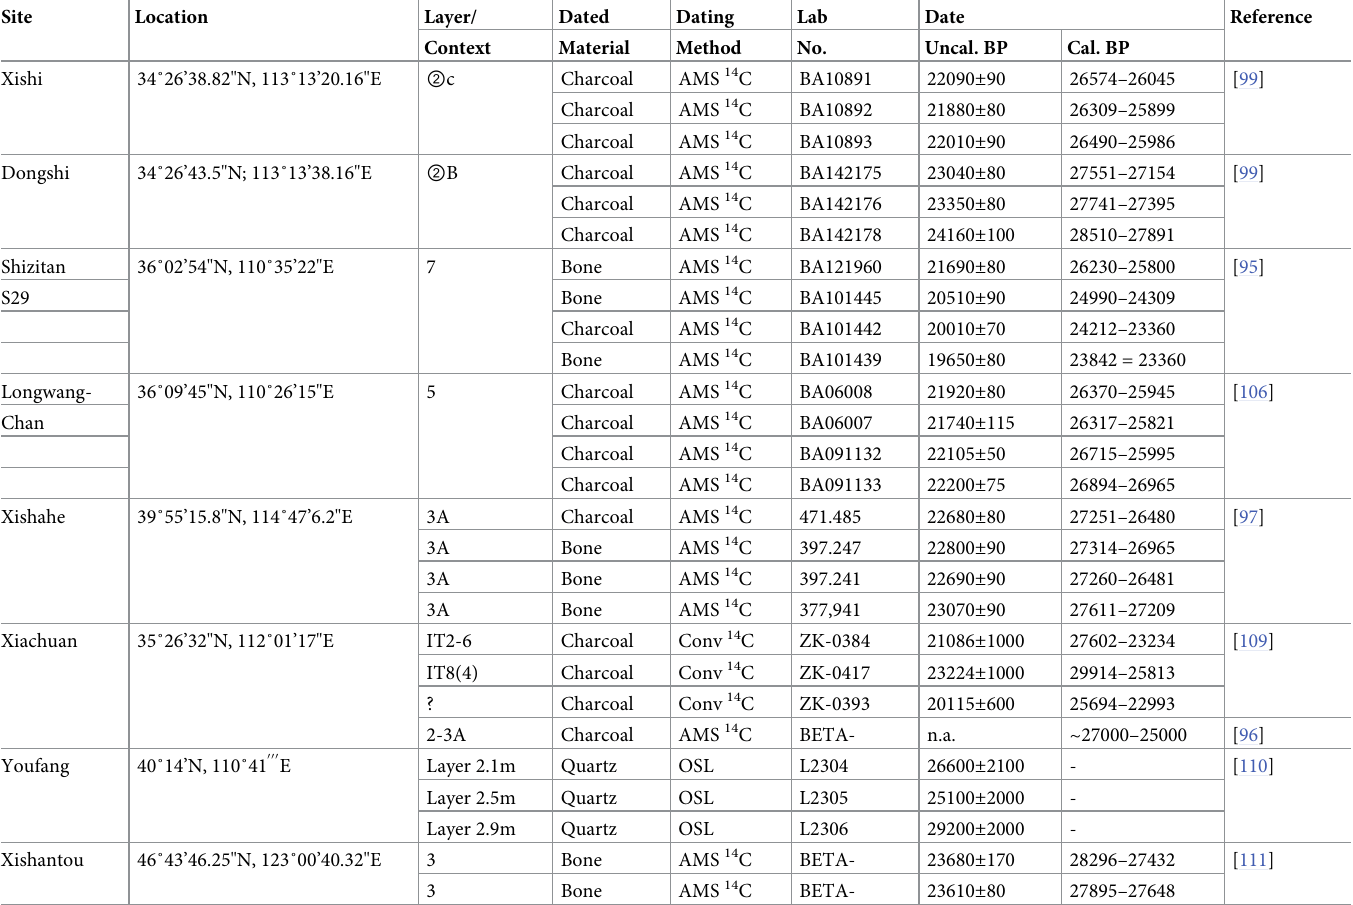
Table 2. Chronological information about the site stratum with coexisted blade and microblade remains. The radiocarbon data was calibrated by using OxCal 4.4 and IntCal20 calibration curve.